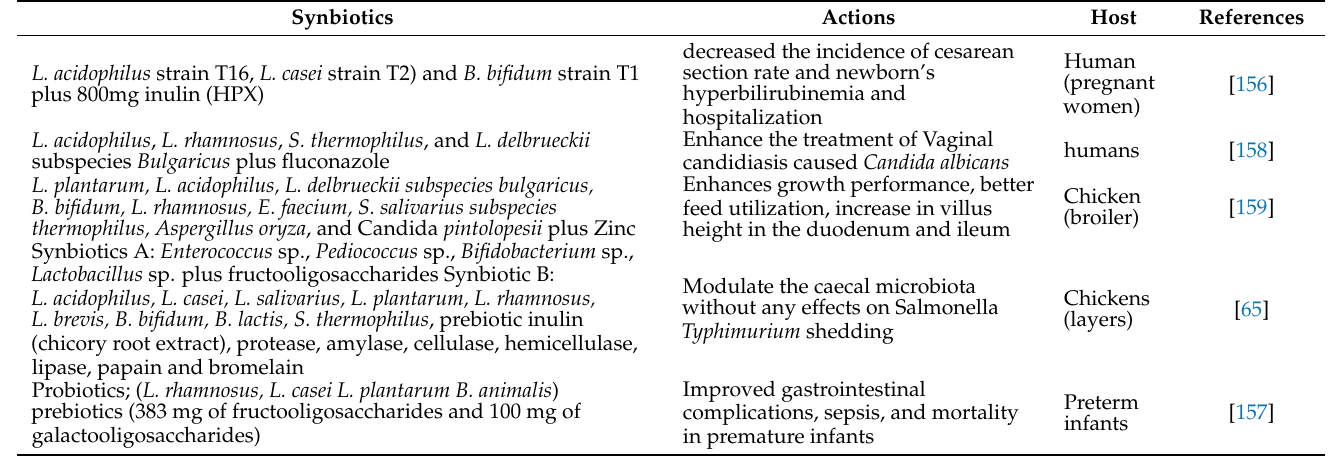
Table 3. Use of multi-strain probiotics along with other